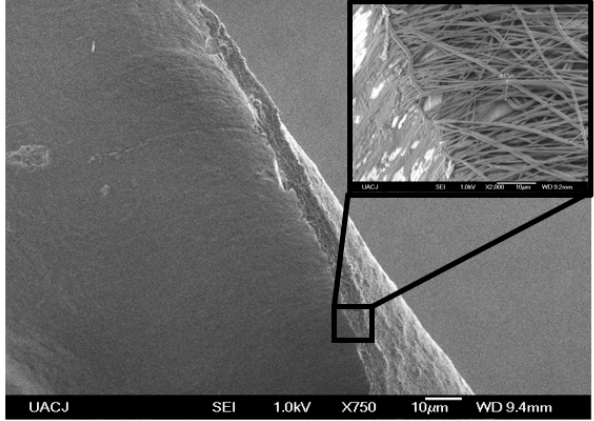
Figure 12. SEM image (750×) of the side perspective of a film obtained with the β -CD-NH 2 /PCL in the TFE electrospinning process (inset 2000×).